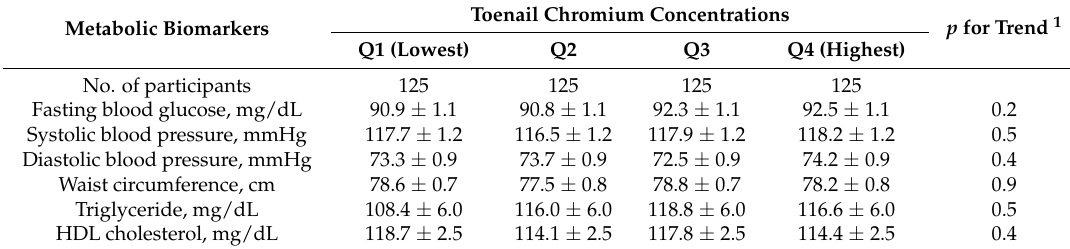
Table 2. Metabolic biomarkers of participants according to quartiles of toenail chromium concentrations, the SELEN study ( n = 500).